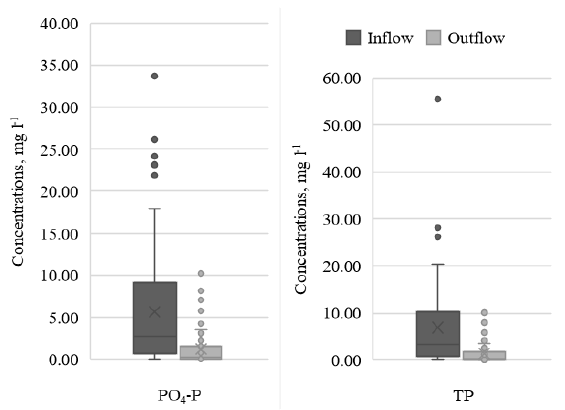
Fig. 5. Box plots for PO 4 -P and TP at the inflow and outflow of the treatment system. For PO 4 -P and TP concentrations the retention indicates high percentage when overall ratio between inlet and outlet concentrations is compared, 78 % and 80 %, respectively. Boxplots in Fig. 5 indicates again a low symmetry of data set and the second quartile of the outflow is located slightly under the second quartile at the inflow. The interquartile ranges are reasonably different for inflow and outflow as shown by length of the boxes though the overall range of the data set is greater for the inflow concentrations. We can consider that PO 4 -P and TP concentrations were reduced during the treatment process. The filter material for more optimal P sorption could be integrated in the constructed wetland with a purpose to improve the removal efficiency of phosphorous compounds in the wetland [17]. A weak relationship between retention, % and inflow concentrations, mg L − 1 for TP was